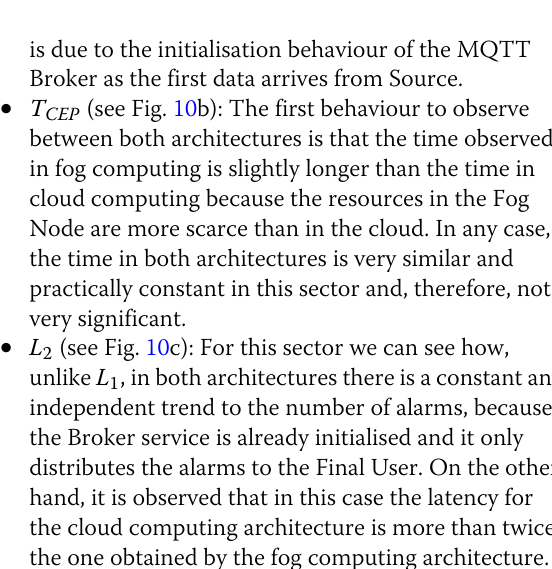
in the cloud computing architecture, has a more stable value, independently of the assigned